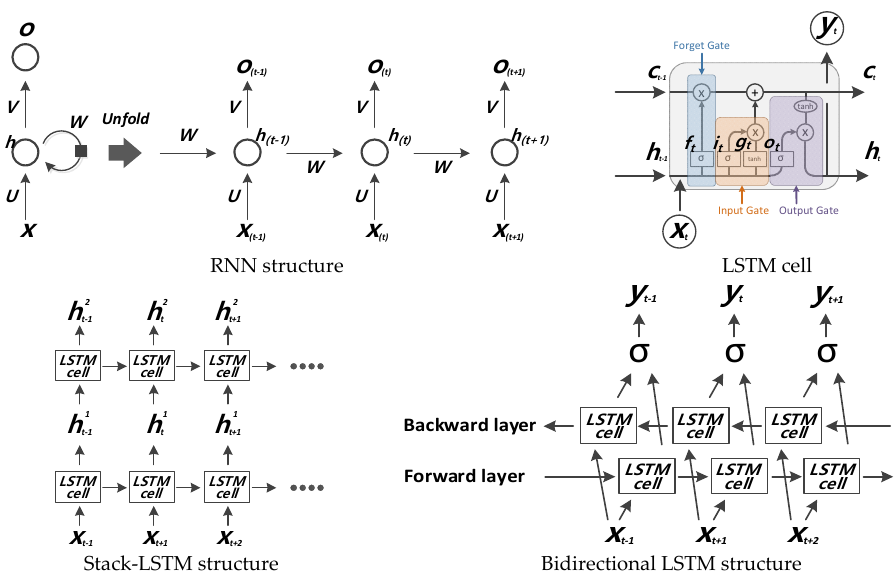
Figure 4. Typical structure of deep learning models.